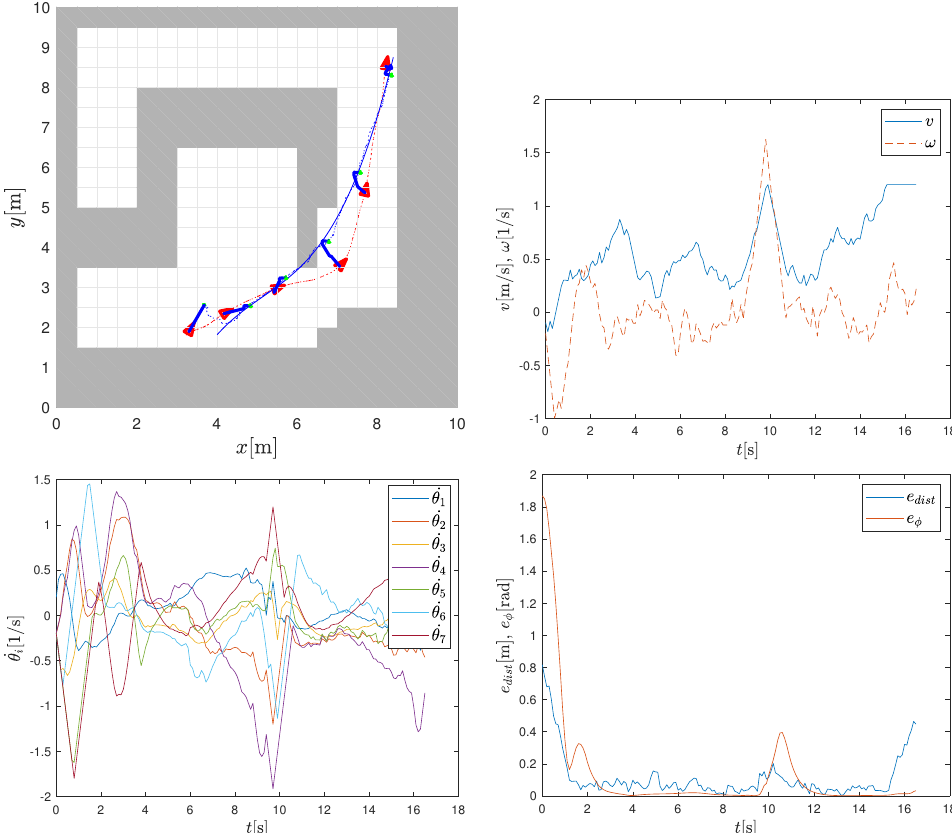
Figure 7. Trajectory tracking with added noise in actions (top left) showing reference trajectory of arm (solid blue line), the obtained motion (dotted blue line), and base trajectory (dotted red line); velocities of the mobile base (top right), velocities of the arm joints (bottom left), and tracking distance error and orientation error norm (bottom